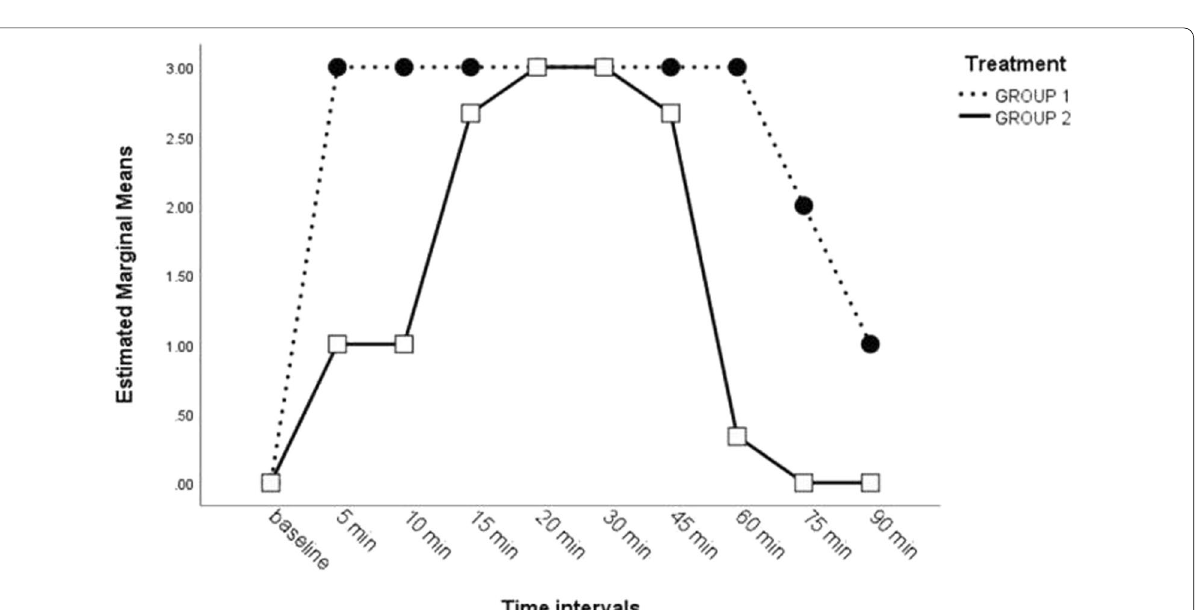
Fig. 1 Line chart shows the means of palpebral reflex for the two groups at different time